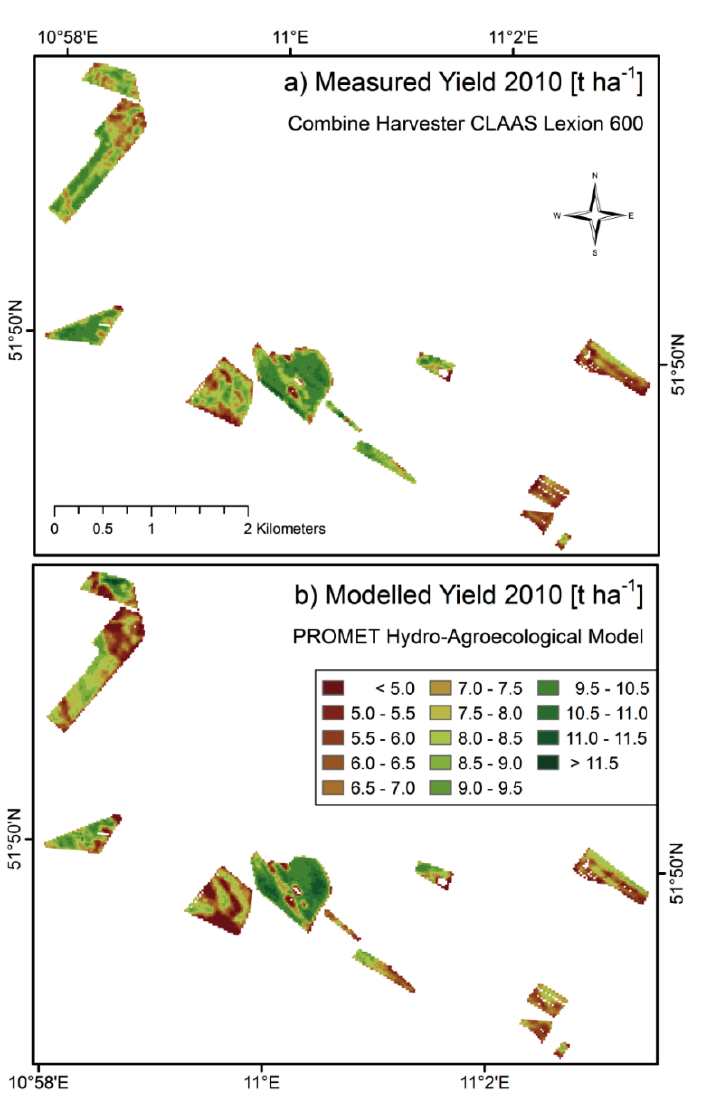
Figure 7. Spatial comparison of measured ( a ) and modelled ( b ) yield of winter wheat fields from the harvesting season of 2010 in northern Germany. Both maps are calculated for a spatial resolution of 20 × 20 m. The surface area of the displayed winter wheat fields amounts to >180 ha. A quantitative comparison is given in Figure 8 and Table